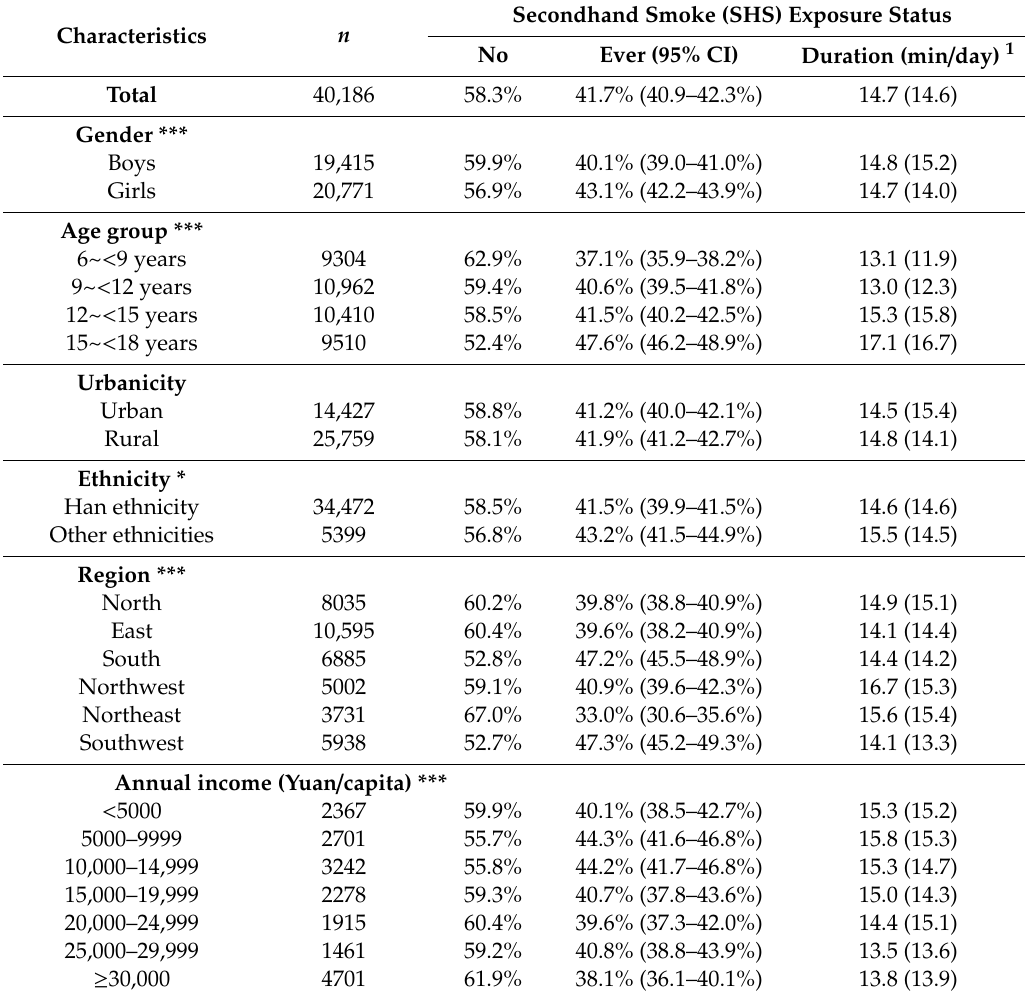
Table 1. Secondhand smoke (SHS) exposure status by subgroups of the study population.